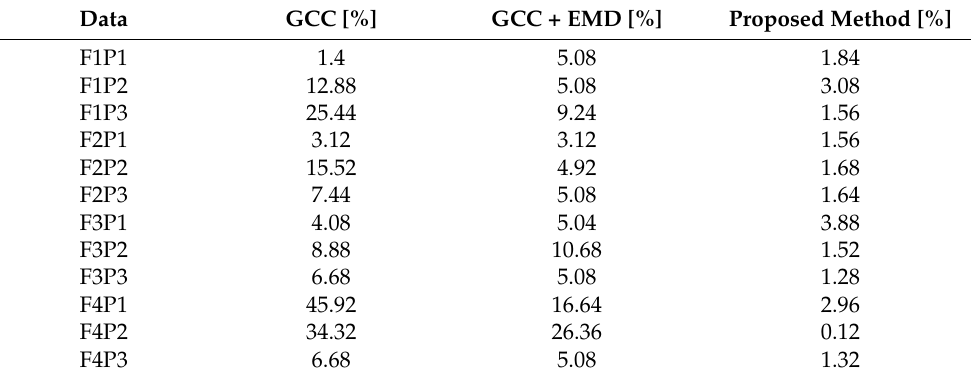
Table 4. Relative error of the tested